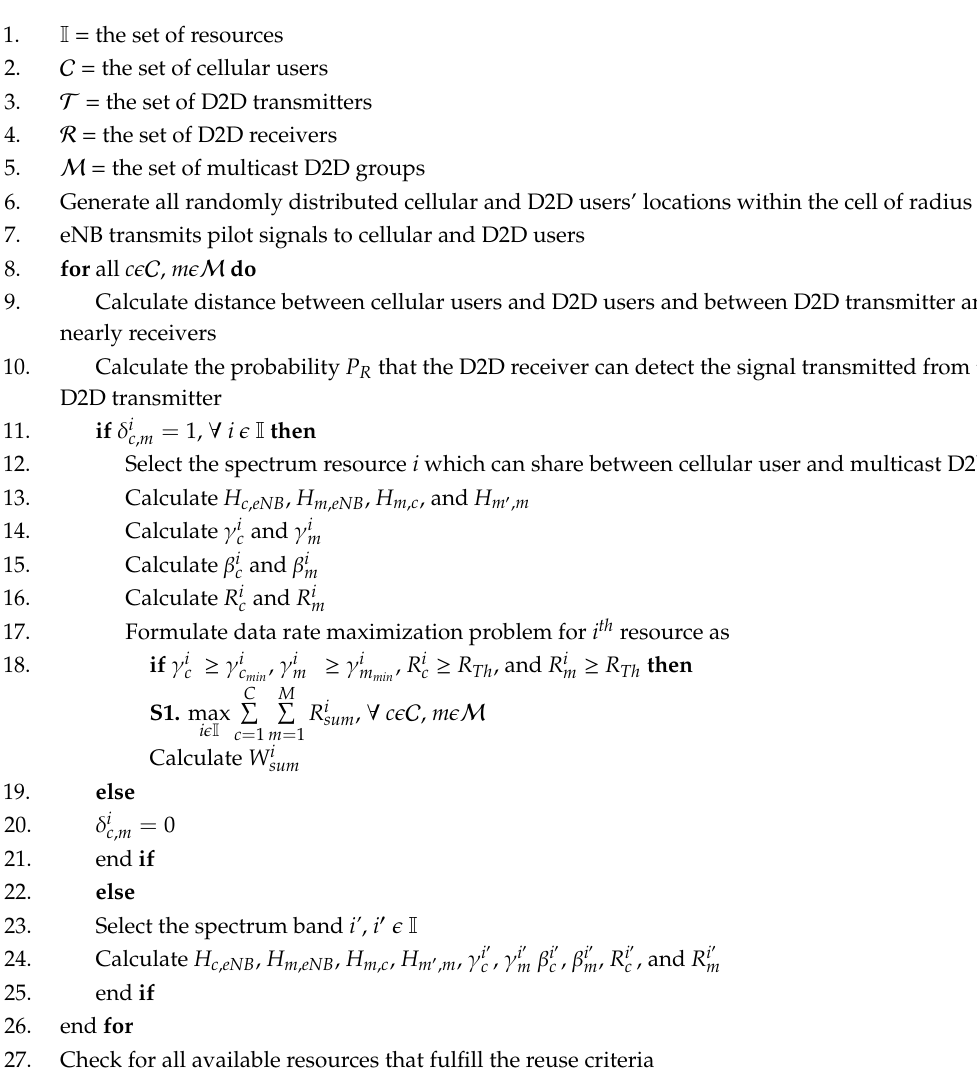
Algorithm 1 : Pseudo Code for the RA